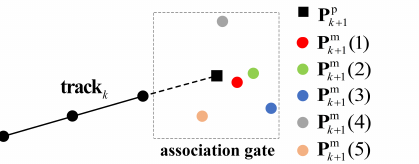
Figure 5. Schematic diagram of plot-to-track association